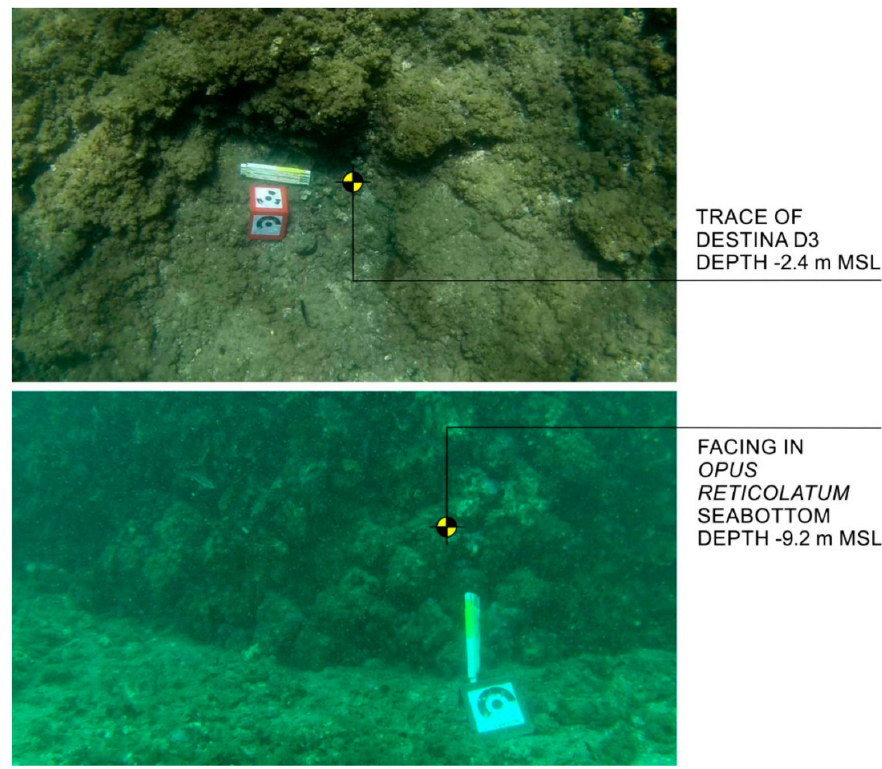
Figure 23. Underwater photo taken during the direct